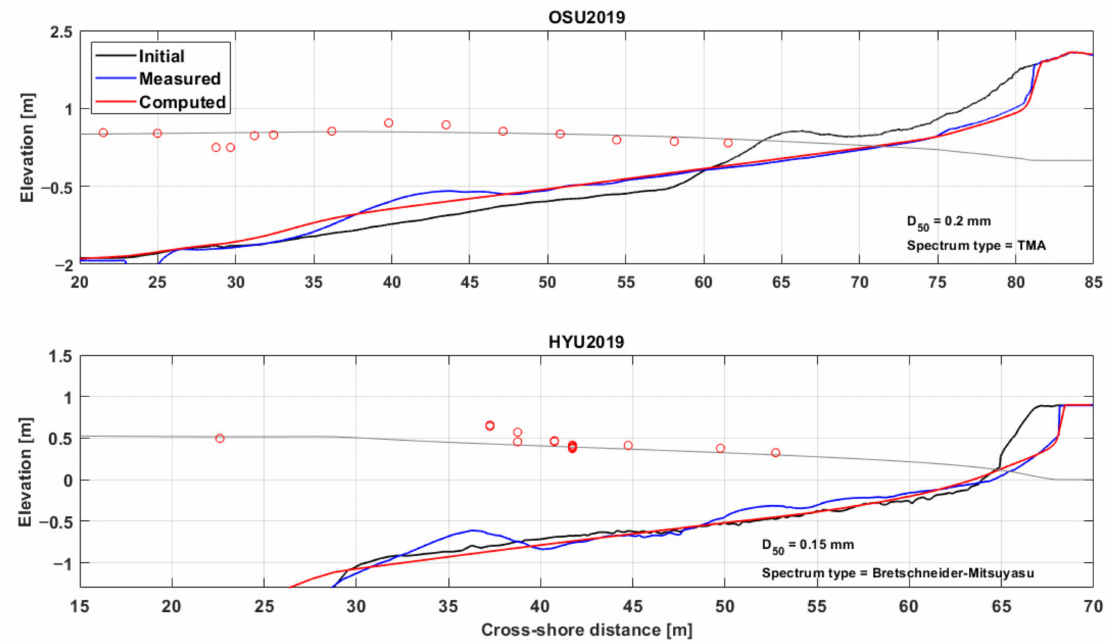
Figure 9. Initial (black), final measured and computed profile (blue and red, respectively), and significant wave height (gray solid line: simulated, red circle: measured) of two experiments ( upper panel : OSU2019, lower panel :